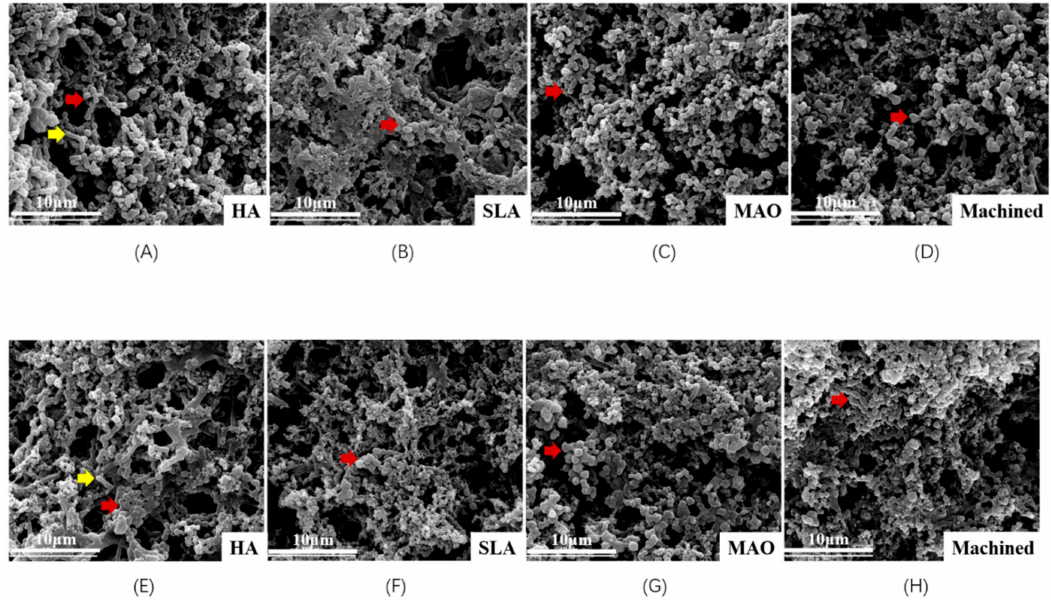
Figure 2. The structure of saliva-derived biofilms (periodontitis and health) on titanium discs was observed by scanning electron microscopy (SEM). ( A – D ) Periodontitis saliva-derived biofilms on HA, SLA, MAO, and machined titanium; and ( E – H ) healthy saliva-derived biofilms on HA, SLA, MAO, and machined titanium. The red arrows indicate Coccus while the yellow arrows indicate